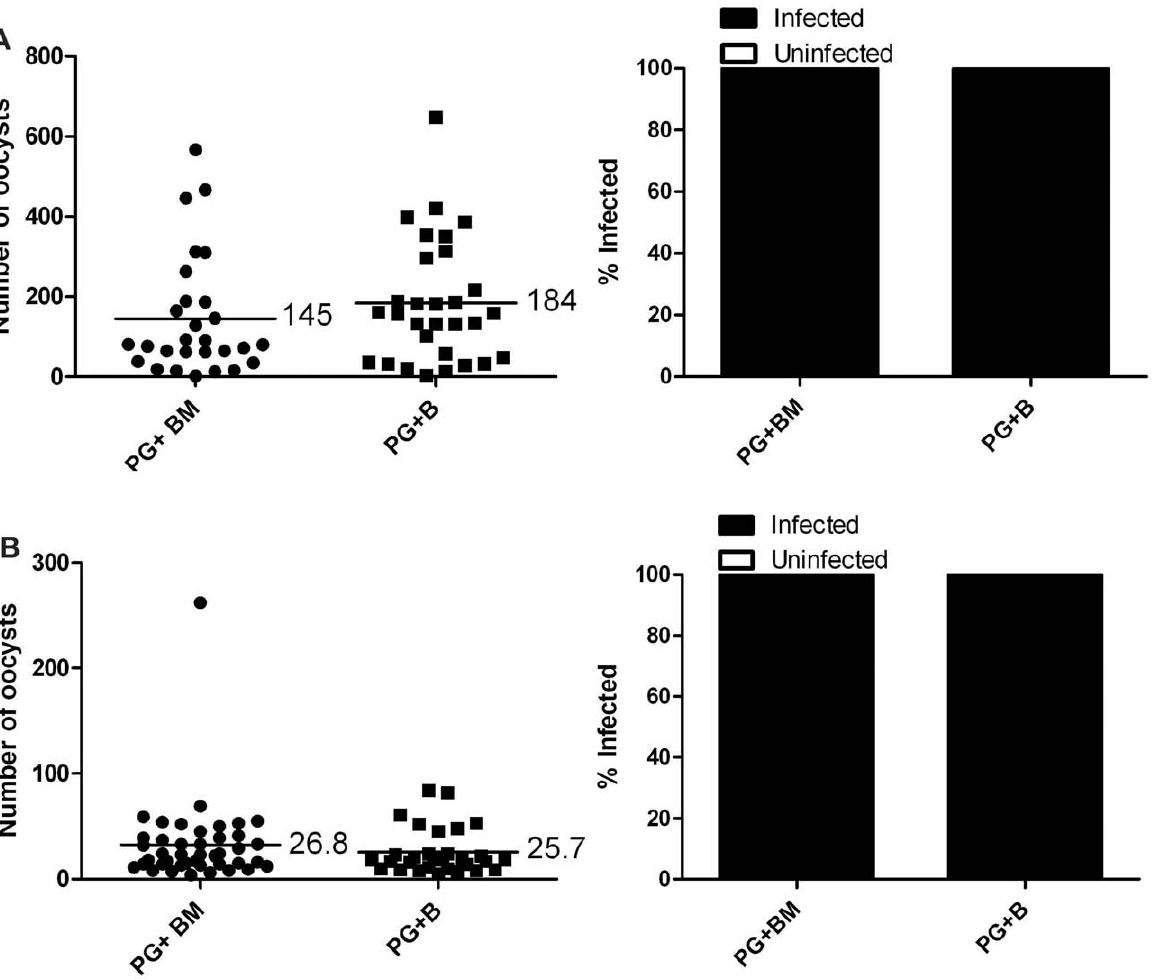
Figure 3. A secondary exposure to B.malayi does not affect Plasmodium development. Mosquitoes that had a primary exposure to P. gallinaceum and a secondary exposure to uninfected blood served as controls. Mosquitoes that had a primary exposure to P. gallinaceum and a secondary exposure to B. malayi served as the experimental group. For both, the left panel indicates infection intensity where points indicate the absolute value of oocyst counts in individual mosquitoes, and horizontal black bars represent the mean intensity. The right panel indicates prevalence of infection where the bars represent the total population of mosquitoes examined. The filled portion of the bars indicates the proportion of mosquito midguts that were positive for at least one oocyst; the unfilled portion of the bar indicates the proportion of midguts that were uninfected. There was no significant difference in Plasmodium development between mosquitoes that received a primary exposure to P. gallinaceum followed by a secondary exposure to uninfected blood or mosquitoes that received a primary exposure to P. gallinaceum followed by a secondary exposure to B. malayi- infected blood. PG, P. gallinaceum ; BM, B. malayi ; B, uninfected blood. A .) Biological replicate number 1, PG + BM n=28, PG + B n=30. B .) Biological replicate number 2, PG + BM n=42, PB + B